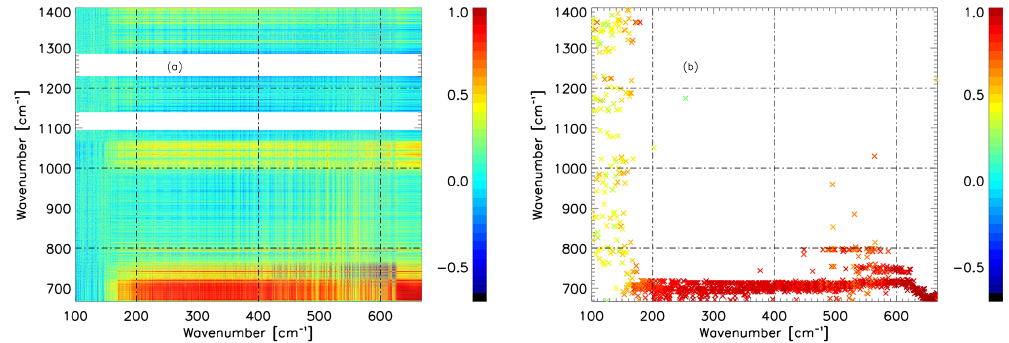
Figure 2. (a) Correlation map using REFIR-PAD clear-sky spectral radiances with MIR wavenumbers on the y axis and FIR wavenumbers on the x axis. (b) MIR wavenumbers that maximise the correlation for each FIR wavenumber. Colour scales indicate the correlation.